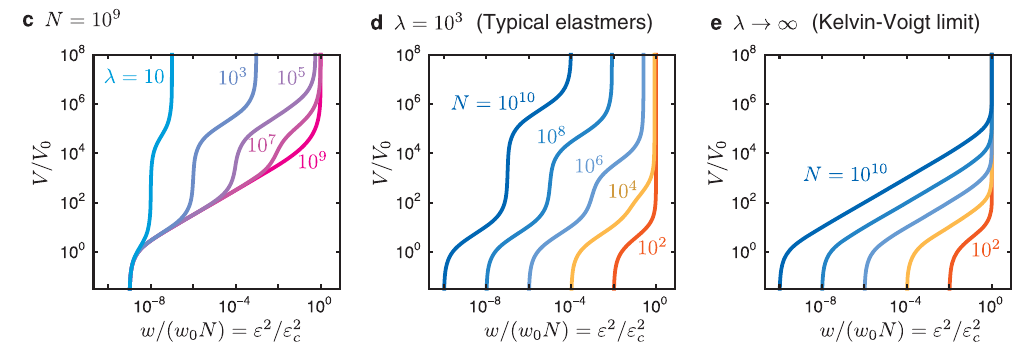
Figure 4. Reproduced velocity jump and simple characterization of the w - V curve. ( a , b ) Two representative plots of the crack propagation velocity V as a function of the initially applied energy density w . The cases ( a ) with and ( b ) without velocity jump are obtained for λ <  N 1 and  λ  N 1 , respectively. (These plots are obtained for ( a ) λ = 10 3 , N = 10 9 and ( b ) λ → ∞ , N = 10 9 ). Four characteristic velocity-scales and three energy- scales are indicated in (a), which are important for toughening. ( c – e ) V / V 0 vs. ε ε = w w N /( ) / equation (1) on a log-log scale. The normalization factors for velocity and energy are η  V lE / ε ≡ w E l , respectively. The cases with velocity jump are demonstrated for various λ with a fixed N in ( c ) and for various N with a fixed λ in ( d ). The Kelvin-Voigt limit, λ → ∞ , is shown for various N in ( e ) as an example of the case without velocity